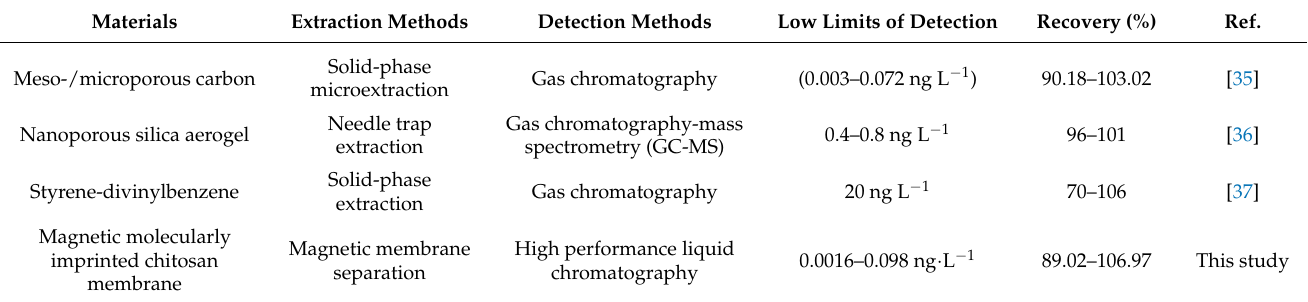
Table 2. Comparison of the present method used to separate the chlorobenzene compounds from environmental water with other reported methods.